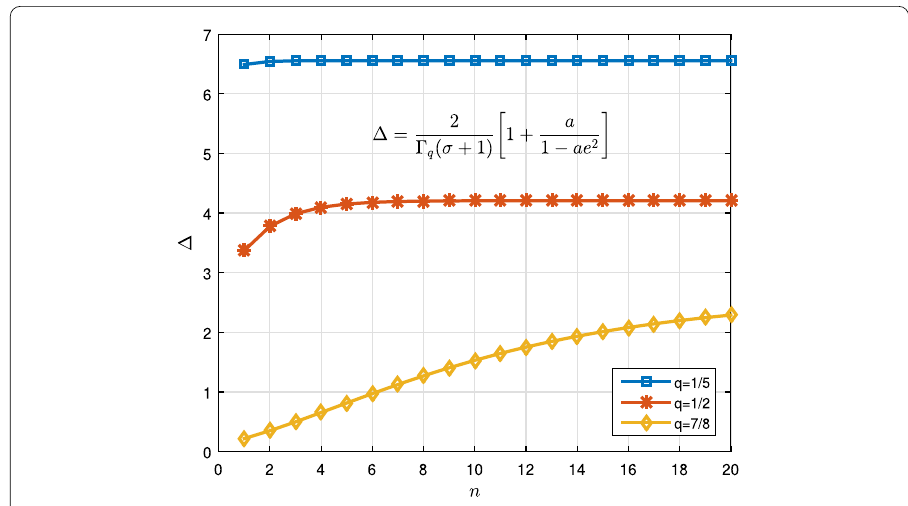
Figure 1 2D graphs of (cid:14) for q = 1